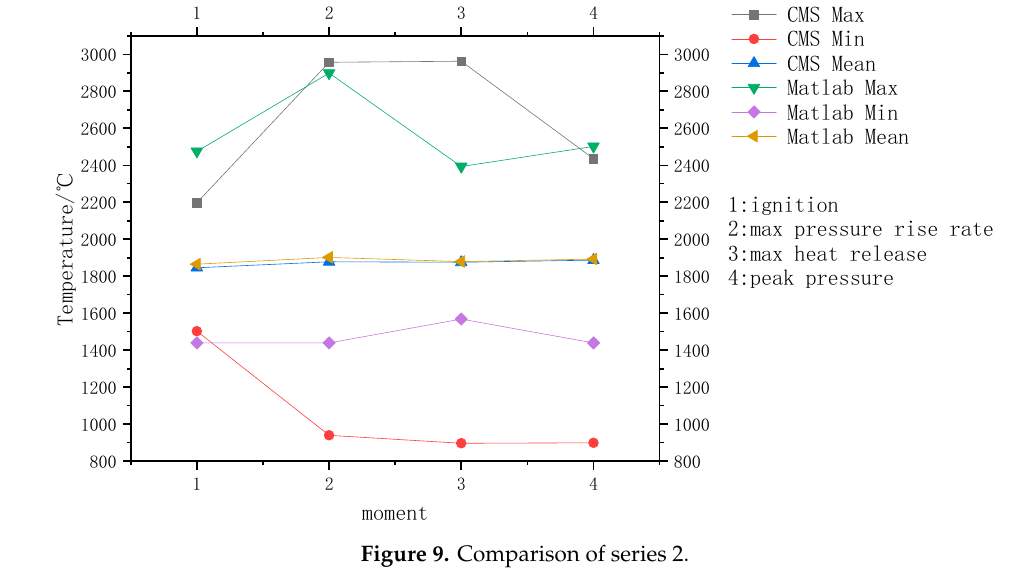
Figure 9. Comparison of series 2. Table 6. Error of typical temperature based on CMS of series